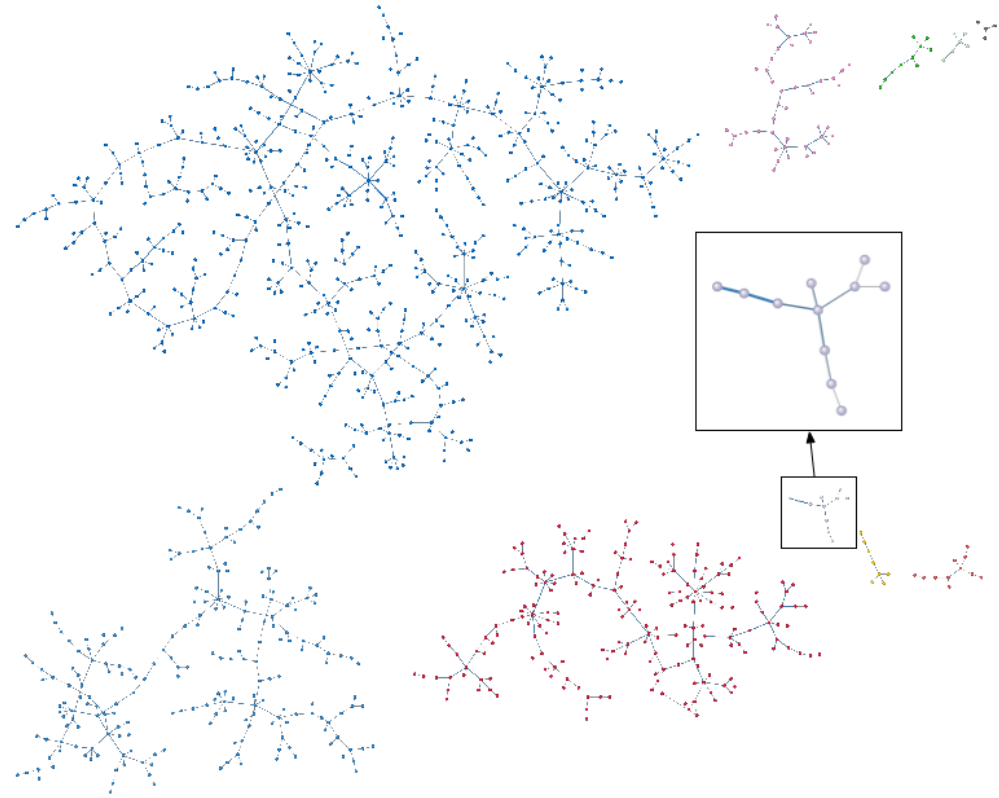
3. Spatial cluster graph for boreal woodland caribou (n = 1226), illustrating the structure of the maximum- weight spanning tree and the resulting 10 groups. Detail of the connections for the west Great Slave Lake group (northeast of Fort Providence) is illustrated in the inset. Each node (circle) is an individual caribou. Edges (links) between nodes denote pairs of caribou sharing the most mutual information, with thicker edges representing closer spatial relationships ( i.e., the weights in the spanning